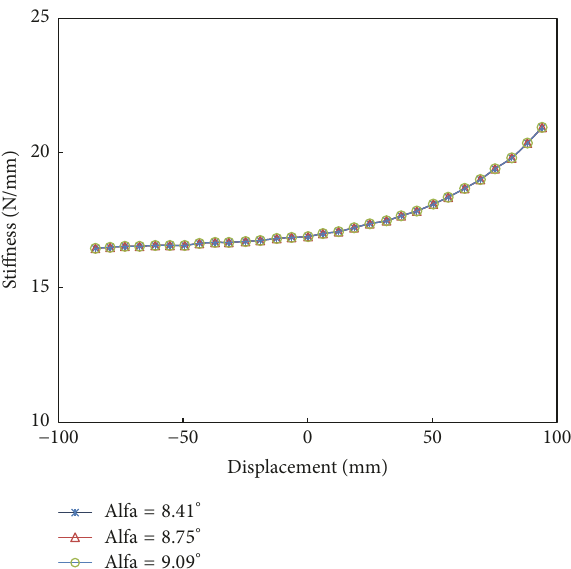
bar diameters of 25 mm, 26 mm, and 27 mm, respectively, and with the diameter variable value of 3.85% compared with the median of 26 mm.